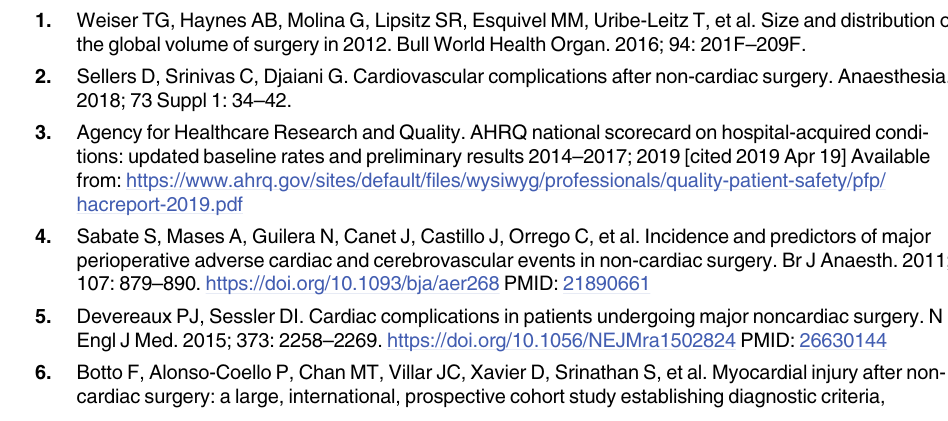
S1 Table. PRISMA checklist. S2 Table. Characteristics of the studies included in the systematic review. S3 Table. Methodological quality